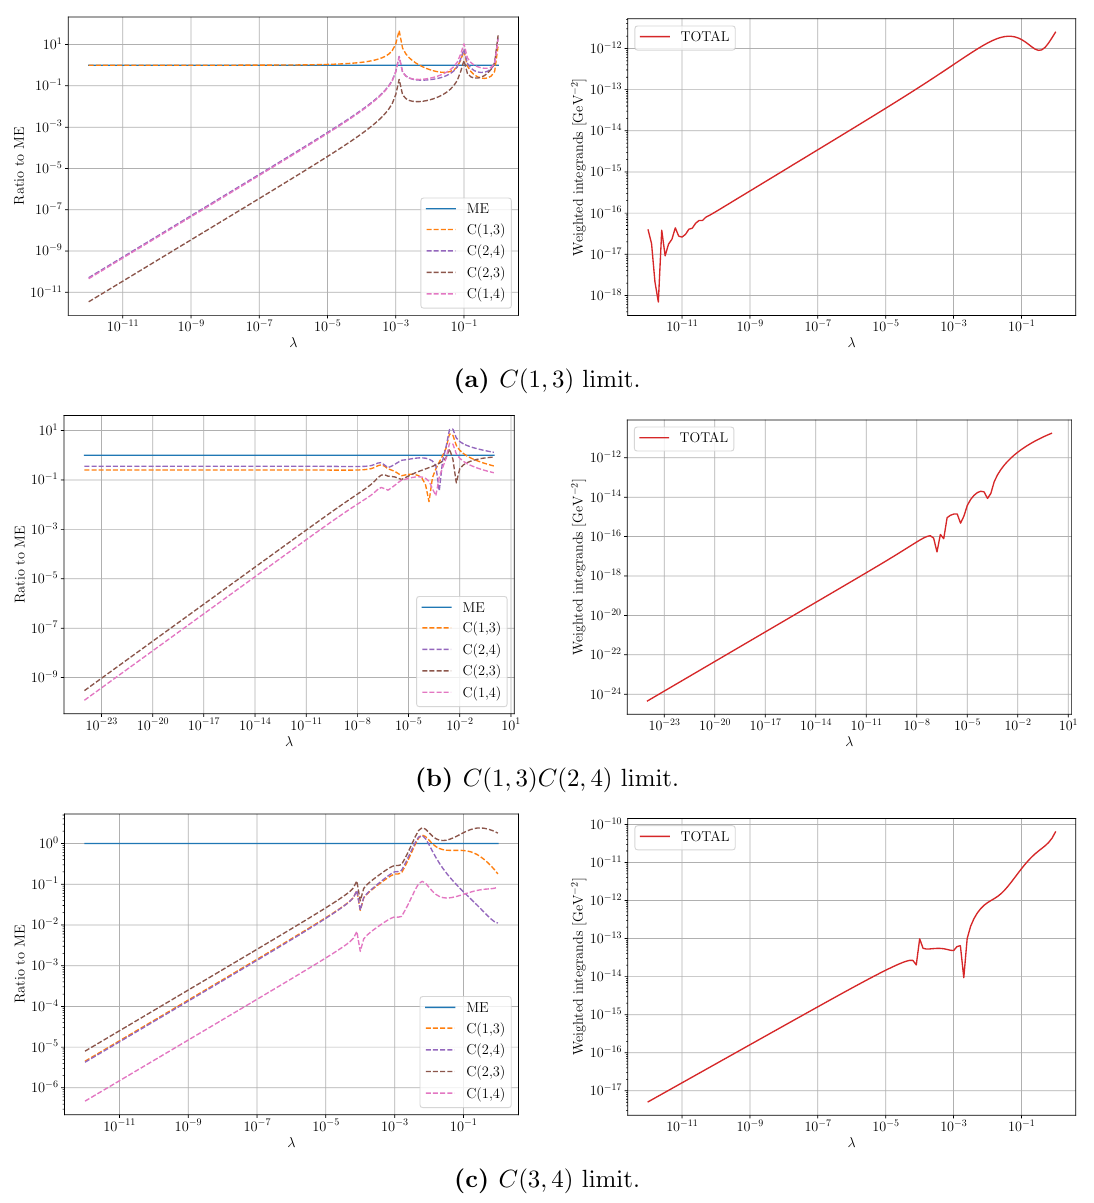
Figure 4 . Behaviour of the terms in eq. (3.1) for the process g 1 g 2 di(cid:11)erent unresolved limits. See text for